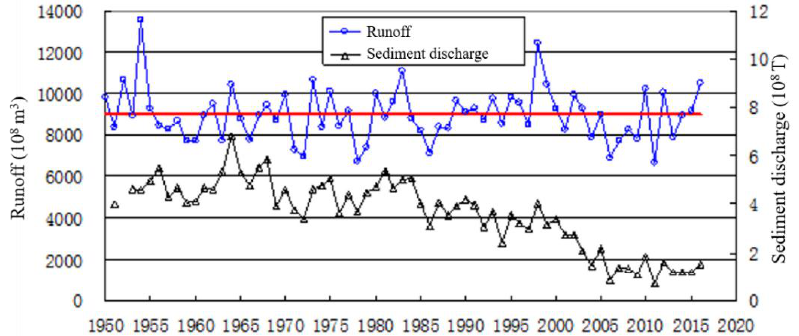
Figure 7. Changes in runoff and sediment discharge in Datong hydrographic station over the past decades.